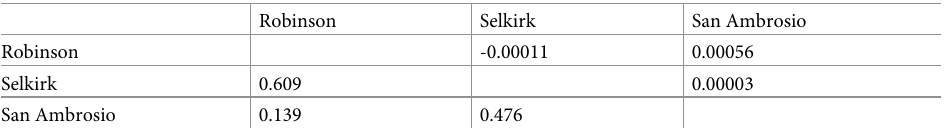
Table 2. Pairwise F ST (above diagonal) and P-value (below diagonal) values for individuals collected in the islands studied.